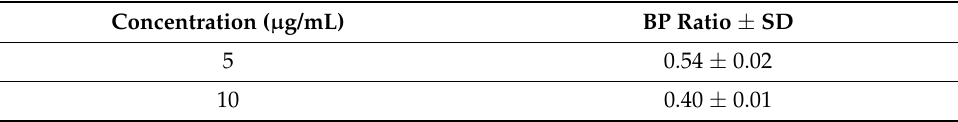
Table 6. Blood/plasma (BP) partitioning allowed for the determination of the BP ratio. Samples of C1 were prepared in the whole blood of rats at concentrations of 5 and 10 µ g/mL ( n = 3) and incubated at 37 ◦ C for 4 h. Plasma was drawn from blood samples and the C1 concentration was established using the RP-HPLC method. The BP ratio was calculated by dividing 5 or 10 µ g/mL by the corresponding concentration in plasma separated from blood samples. Data are expressed as the BP ratio ±